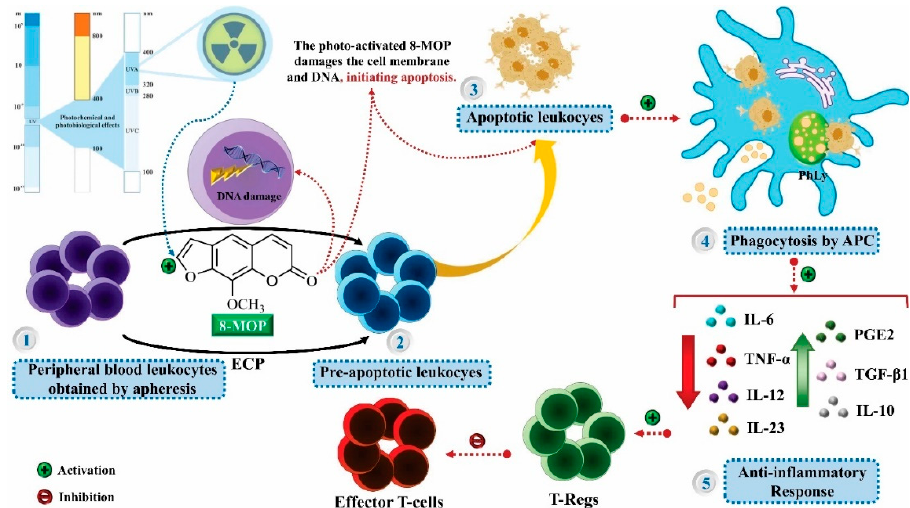
Figure 3. Use of furanocoumarins in the technique of extracorporeal photopheresis for the treatment of systemic or multifocal diseases: Leukocytes obtained by apheresis are exposed to 8-metoxipsoraleno (8-MOP), which is activated by UVA radiation and covalently binds to the DNA of these cells, causing damage and inducing apoptosis within 48 h. Pre-apoptotic leukocytes are reintroduced into the peripheral circulation, being recognized and phagocyted by antigen-presenting cells in phagolysosomes. This recognition induces tolerogenic anti-inflammatory response, which reduces the production of pro-inflammatory cytokines like IL-6, IL-12, IL-23, and TNF- α and increases the production of anti-inflammatory cytokines like IL-10, TGF- β 1, and PGE2 [104]. 8-MOP, 8-metoxipsoraleno; IL-6, interleukin 6; IL-10, interleukin 10; IL-12, interleukin12; IL-23, interleukin 23; TGF- β 1, Transforming growth factor beta 1; TNF- α , Tumor Necrosis Factor-Alpha. Another technique that uses furanocoumarins is extracorporeal photopheresis (ECP), which treats systemic or multifocal diseases such as Crohn’s disease, type 1 diabetes mellitus, multiple sclerosis, and rheumatoid arthritis. In this technique, the most used furanocoumarin is 8-methoxypsoralen (8-MOP), to which leukocytes, obtained by apheresis, are exposed. 8-MOP is activated by radiation and covalently binds to leukocyte DNA, leading to apoptosis within 48 h. These pre-apoptotic leukocytes are reintroduced into the peripheral circulation, where are recognized and phagocyted by antigen-presenting cells in phagolysosomes. This recognition induces a tolerogenic anti-inflammatory response that leads to a reduction in the production of pro-inflammatory cytokines IL-6, interleukin-12 (IL-12), interleukin-23 (IL-23) and TNF- α and induces the production of anti-inflammatory cytokines such as interleukin-10 (IL-10), transforming growth factor beta 1 (TGF- β 1) and prostaglandin E2 (PGE2) (Figure 3) [102,104].